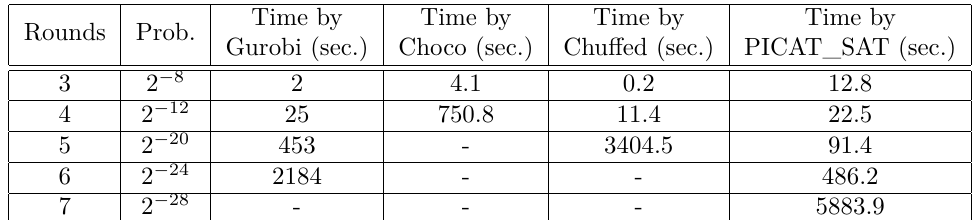
Table 3: Efficiency comparison of Choco, Gurobi, Chuffed and PICAT_SAT in searching for the best differential characteristic of PRESENT, with a time limit of 2 hours. A “-” means timeout.